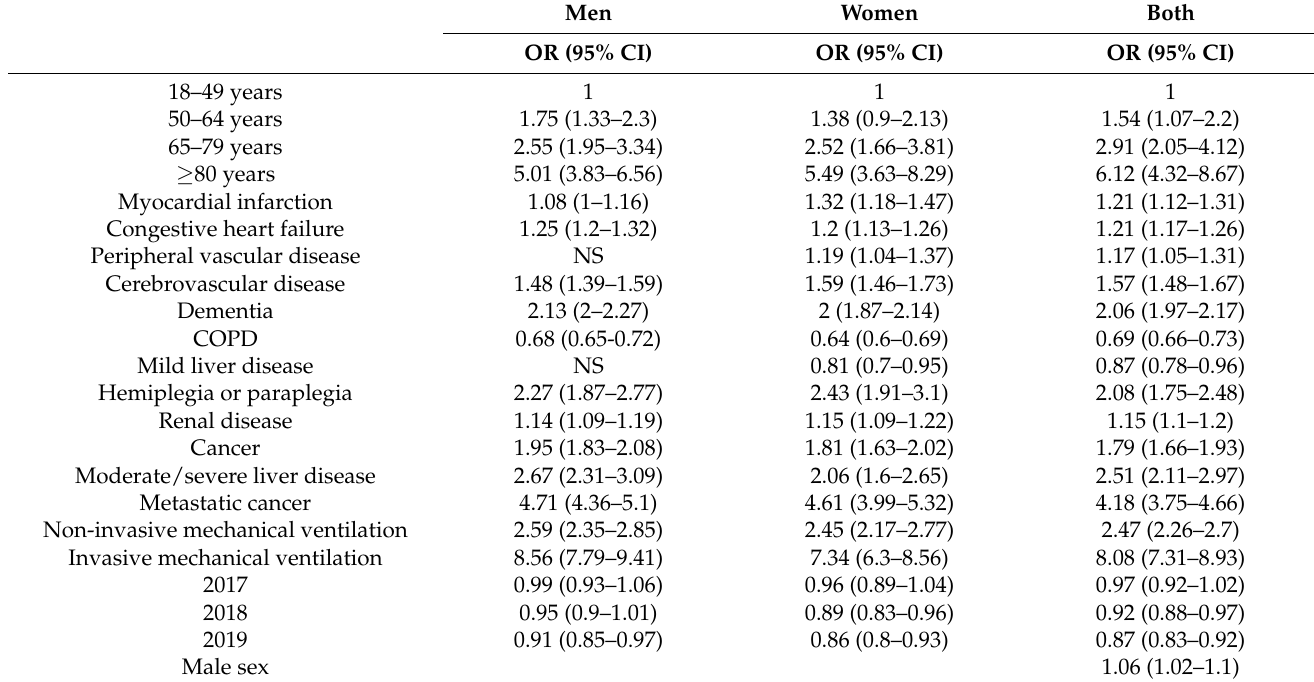
Table 5. Multivariable analysis of factors associated with in-hospital mortality during admissions for community-acquired pneumonia (CAP) among T2DM patients according to